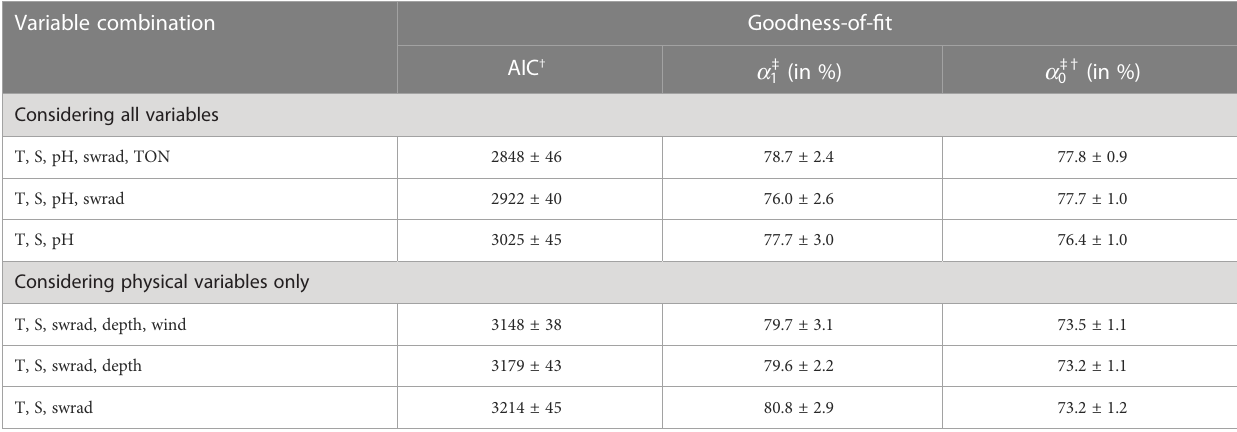
TABLE 3 Optimal variable combination with and without consideration of biogeochemical environmental variables to train the generalized linear model and the corresponding goodness-of- fi t. Variable combination